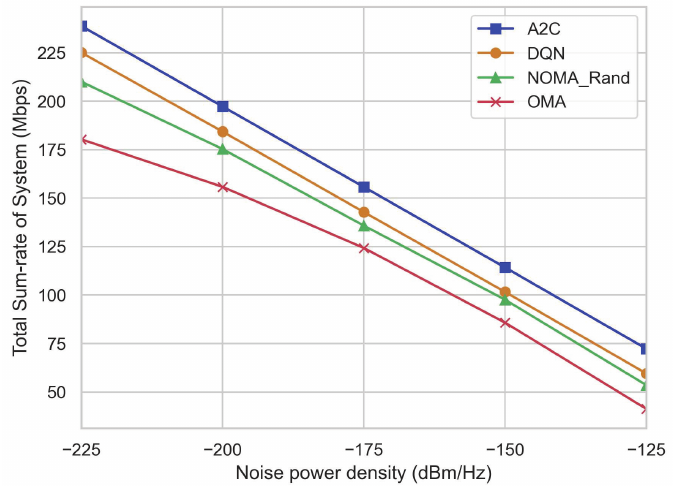
Figure 10. Performance of different algorithms at different noise power